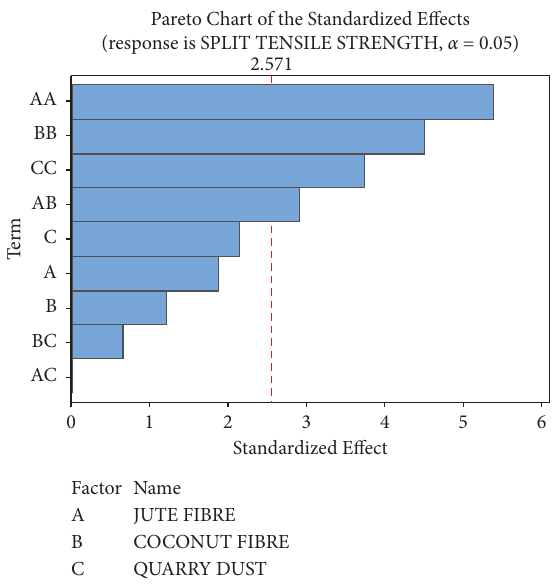
Figure 6: Pareto chart for split tensile strength.